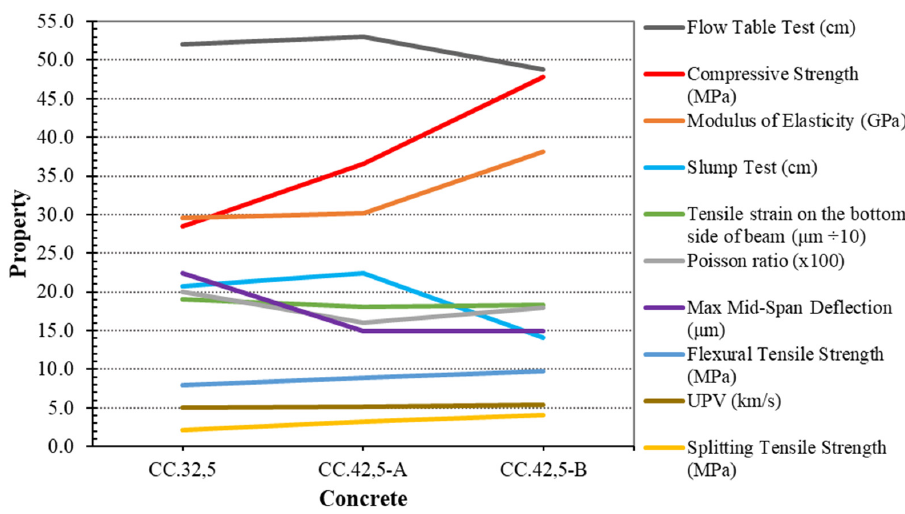
Figure 11. Comparison of the properties of all CC mixtures.